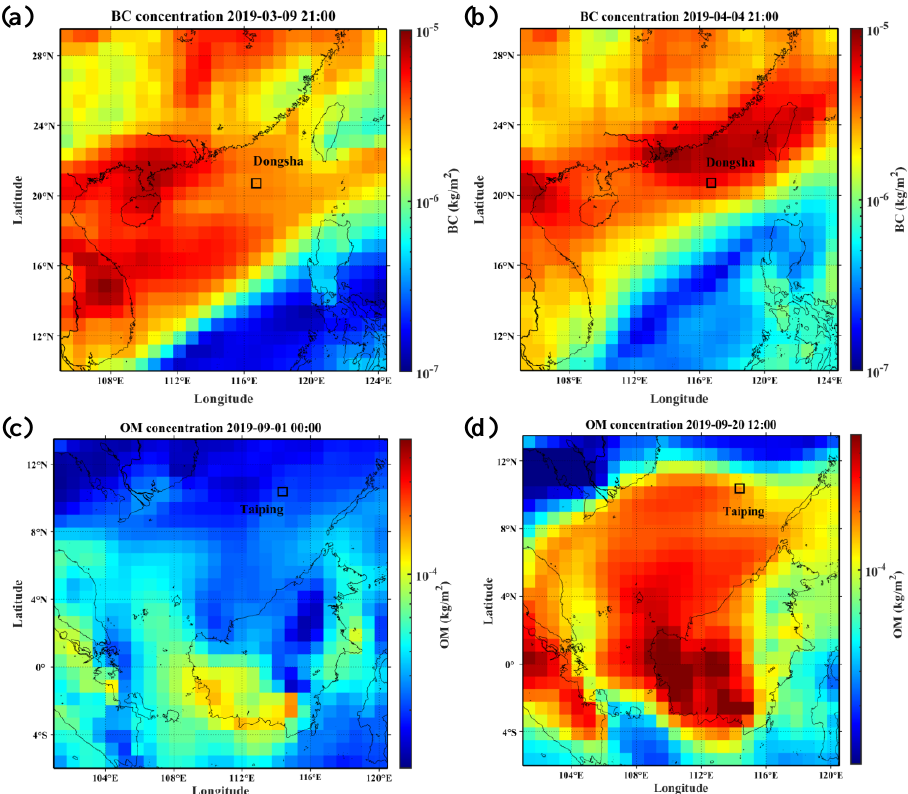
Figure 7. Before ( a ) and after ( b ) the sharp increase in black carbon aerosol loading in the Dongsha area; before ( c ) and after ( d ) the sharp increase in organic matter aerosol loading in the Taiping area.